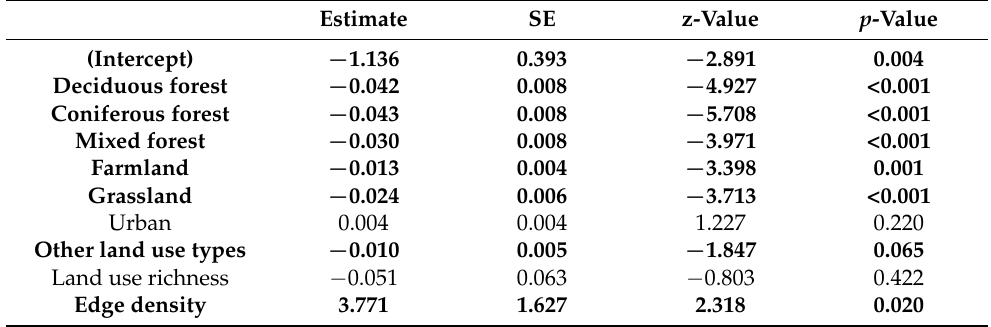
Table 2. GLM model results accounting for the presence and absence of species feral pigeon ( Columba livia forma domestica ) concerning different land use types, land use richness, and edge density in 2016. Abbreviations: SE—standard error. Significant variables are highlighted in